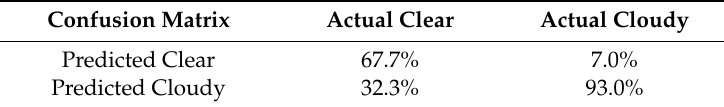
Table 3. Confusion matrix for the GOES-16 Clear Sky Mask product.